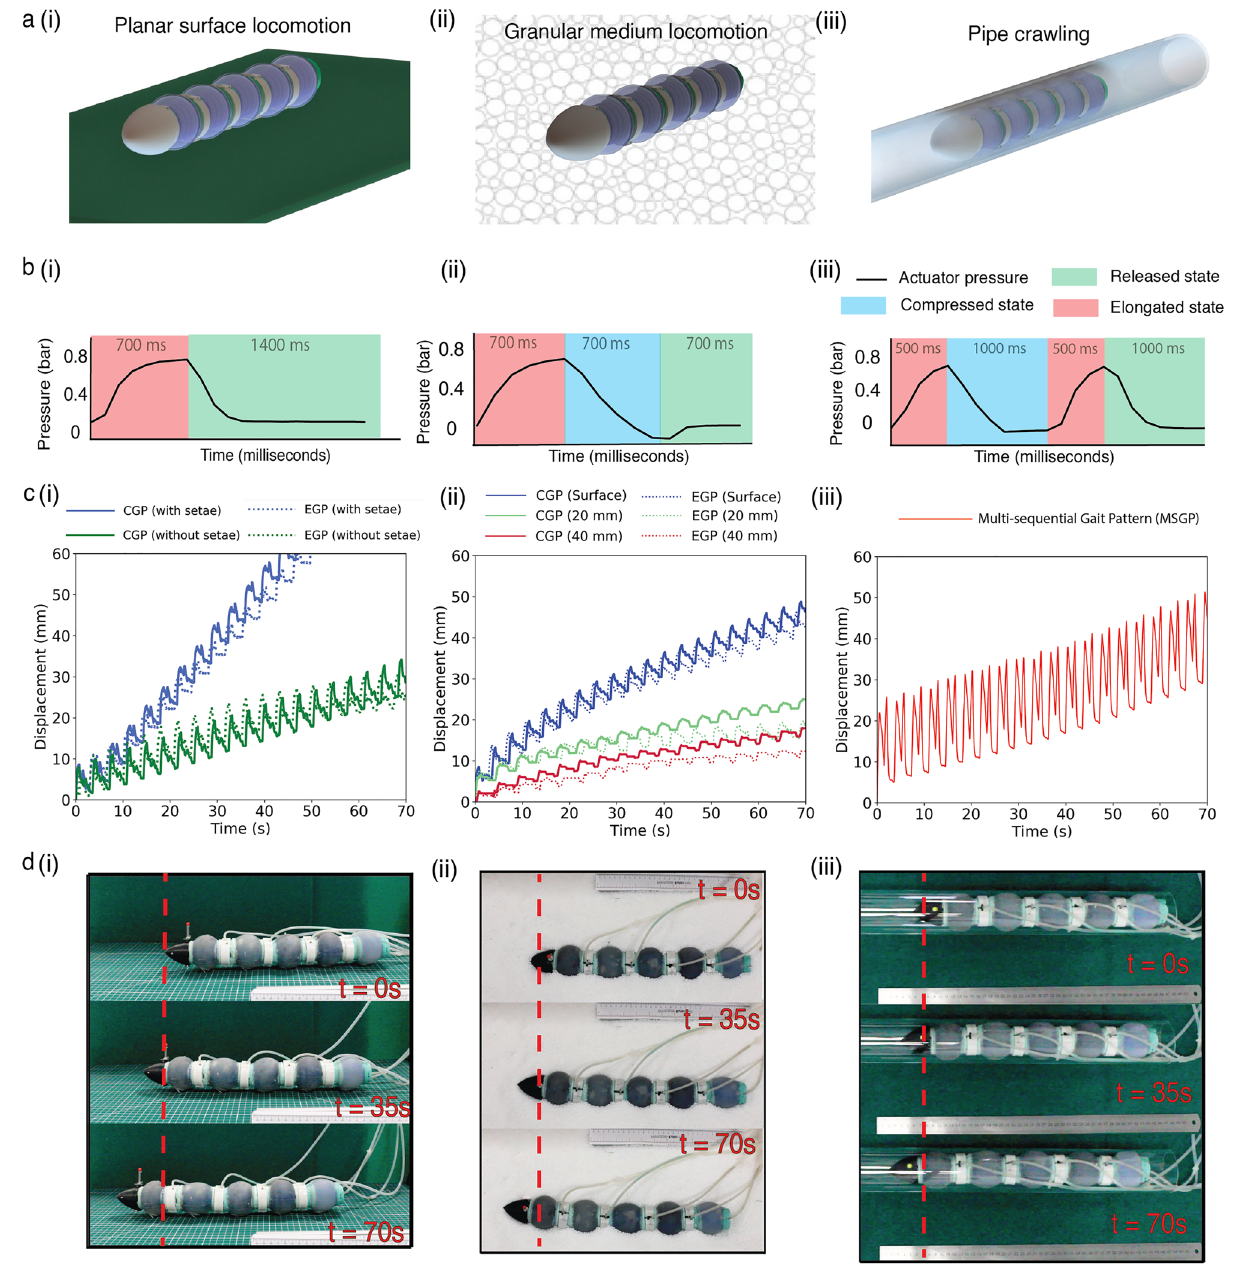
Figure 3. Locomotion performance. ( a) Pictorial representation of robot movement in different mediums (i) planar surface (ii) granular medium (iii) inside a pipe. ( b) Actuator pressure variation with time with different gait patterns in the first module of robot for a single cycle (i) elongation gait pattern (EGP) (ii) combined gait pattern (CGP) (iii) multi-sequential gait pattern (MSGP). ( c ) (i) Locomotion performance illustrating the effect of setae and comparison of CGP and EGP in planar surface locomotion (ii) Locomotion performance in granular medium showing the comparison of CGP and EGP on the surface and at depths of 20 mm and 40 mm. (iii) Locomotion performance of the robot in a pipe. ( d) Locomotion in different environment with time stamps (i) planar surface (ii) granular medium surface (iii) pipe